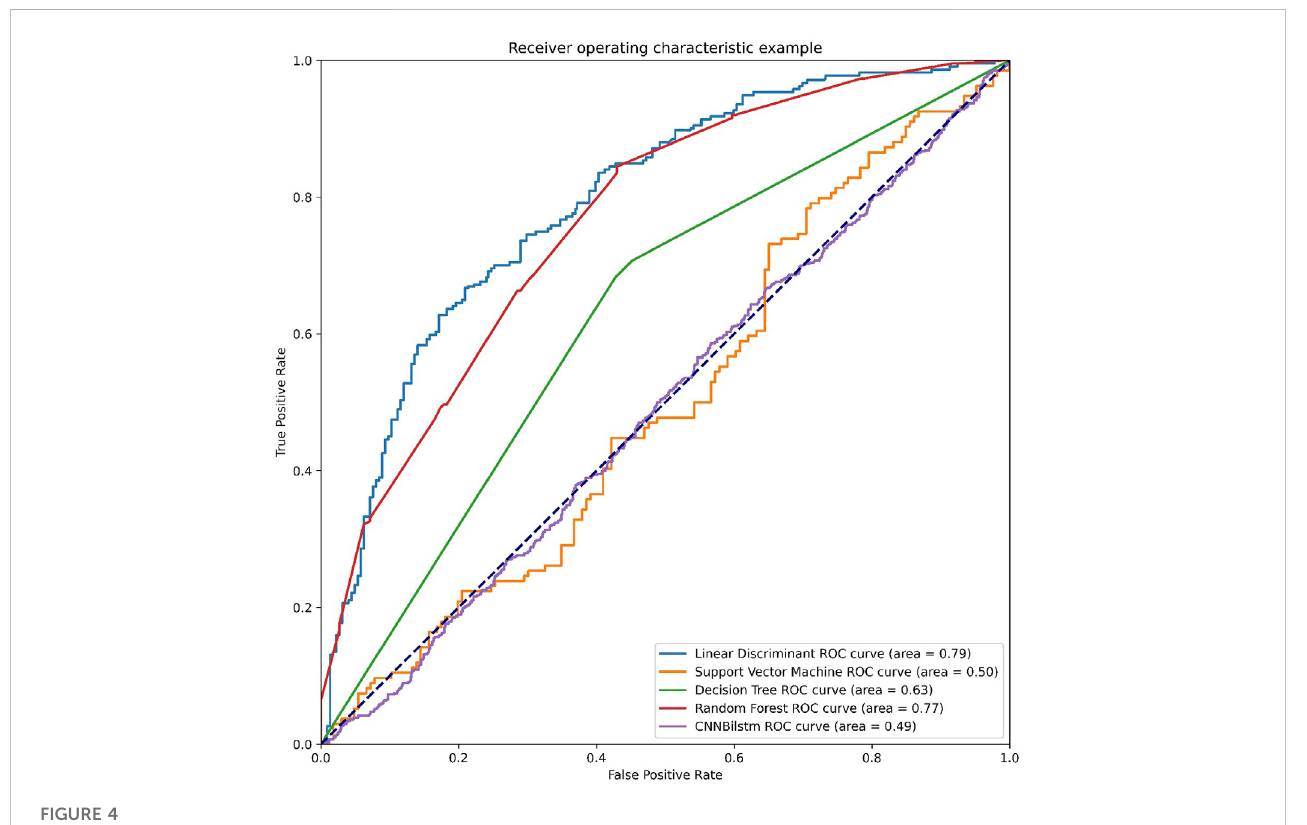
FIGURE 4 The ROC curves of CSKAAP feature.